Question: Which kind of chart has been used to present this data?
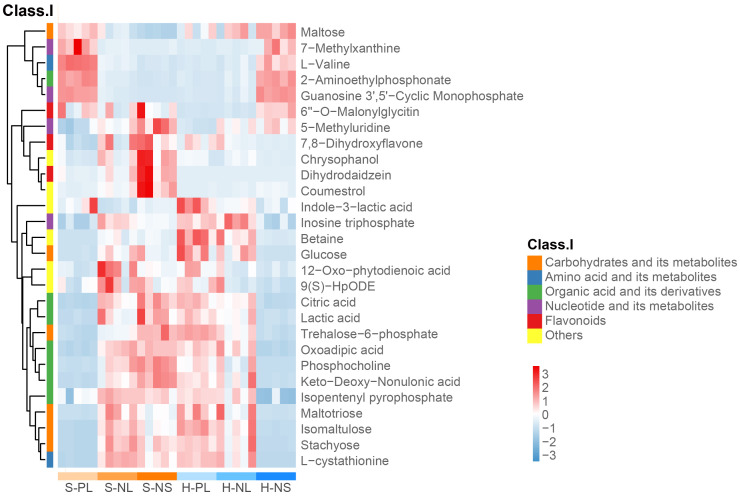
Answer: heatmap